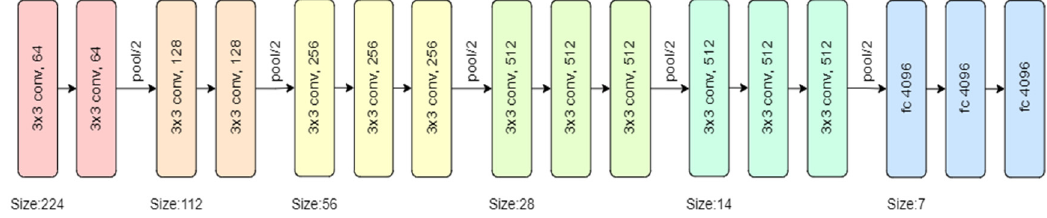
Figure 6. VGG-16 model architecture.